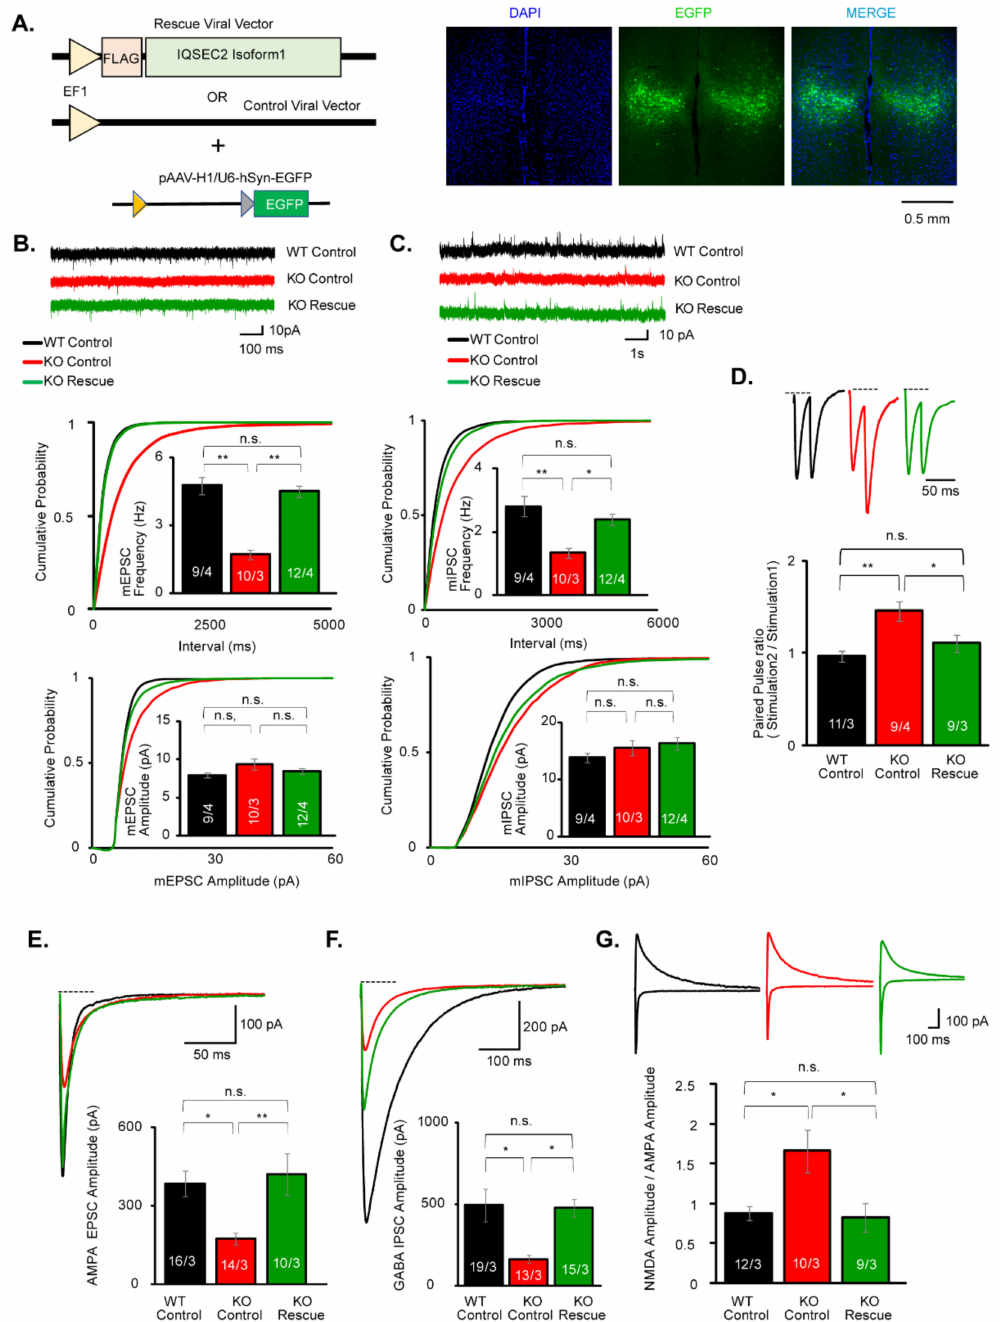
Figure 5. Re-expression of IQSEC2 isoform 1 rescues the impaired synaptic transmission in the pyramidal neurons in layer 5 of the mPFC in IQSEC2 KO mice. ( A ) Schematic diagram for AAV vectors used for IQSEC2 rescue, control, and EGFP marker (left). Representative confocal microscopic images of AAV-injected brain slice containing both hemispheres of mPFC. Scale bar = 0.5 mm. ( B ) Sample traces and summary graphs for mEPSCs in wild-type infected with control AAV (WT Control), IQSEC2 KO infected with control AAV (KO Control), and IQSEC2 KO infected with IQSEC2 AAV (KO Rescue) pyramidal neurons in layer 5 of the mPFC. The decreased frequency of mEPSCs in IQSEC2 KO neurons is recovered in KO Rescue neurons. ( C ) Sample traces and summary graphs for mIPSCs in wild-type infected with control AAV (WT Control), IQSEC2 KO infected with control AAV (KO Control), and IQSEC2 KO infected with IQSEC2 AAV (KO Rescue) pyramidal neurons in layer 5 of the mPFC. The decreased frequency of mIPSCs in IQSEC2 KO neurons is rescued in KO Rescue neurons. ( D ) Sample traces and summary graph for the paired-pulse ratio of evoked AMPA EPSCs in wild-type infected with control AAV (WT Control), IQSEC2 KO infected with control AAV (KO Control), and IQSEC2 KO infected with IQSEC2